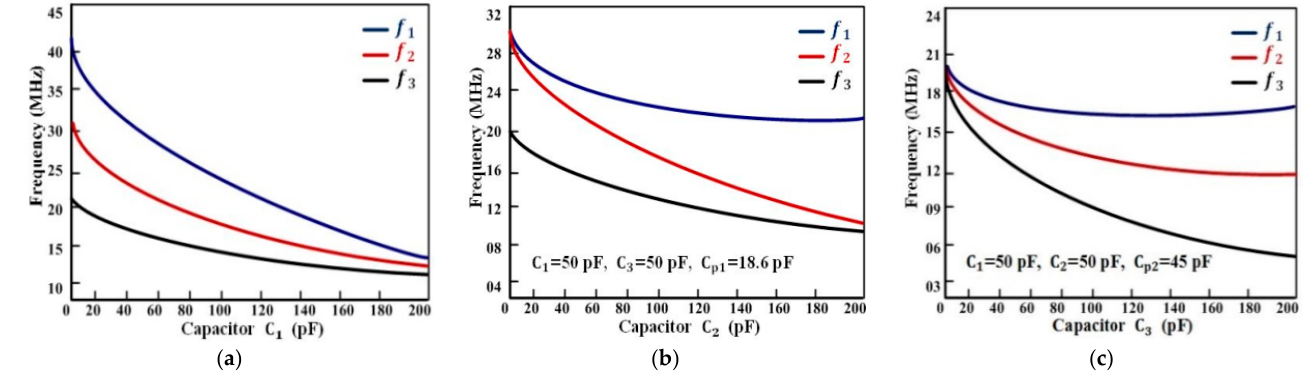
Figure 5. Simulation curves of resonant frequencies versus three capacitors, respectively ( a ) Resonant frequencies versus C 1 when C 2 and C 3 were fixed at 50 pF; ( b ) resonant frequencies versus C 2 when C 1 and C 3 were fixed at 50 pF; ( c ) resonant frequencies versus C 3 when C 1 and C 2 were fixed at 50 pF.